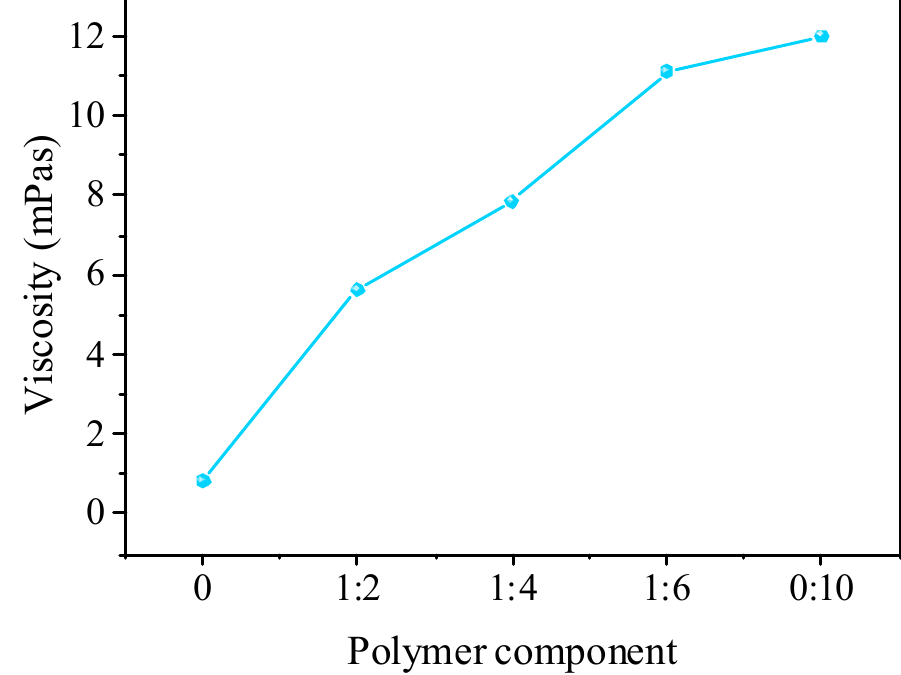
Figure 3. The viscosity of xylan-g-PMMA solutions with different AXU/MMA molar ratios.